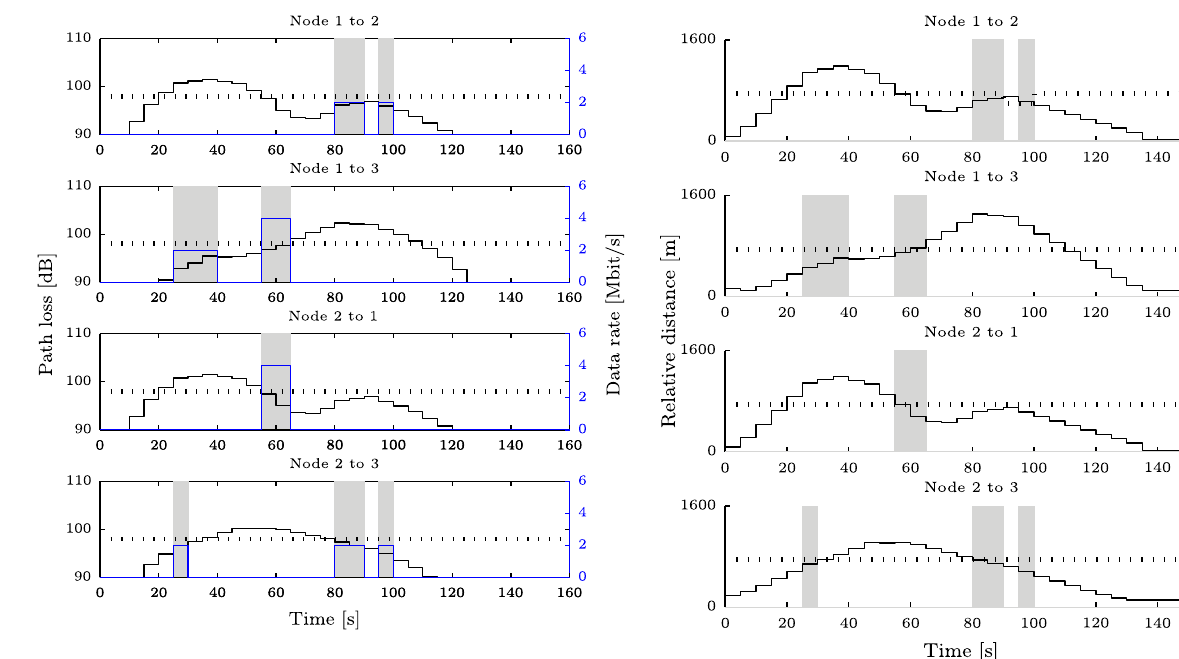
Figure 15: Scenario 2: The calculated path loss us- ing SPLAT! (solid blue), maximum allowed path loss for communication 98 dB (dashed blue), communication data rate (solid blue) and time steps when high bandwidth com- munication is required (shaded grey area) to accomplish the task at the 3rd and final iteration.